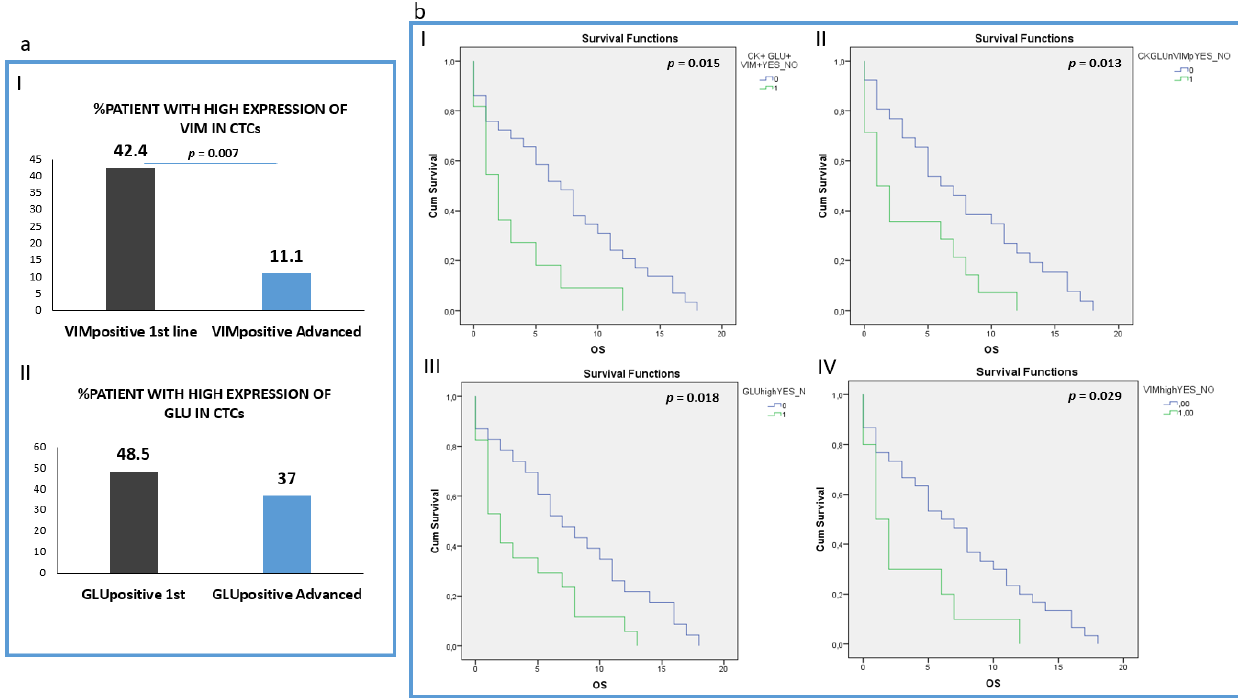
Figure 5. Clinical outcome in NSCLC patients. ( a ) (I) Percentage of treatment naïve (1st line) versus pre-treated (advanced) patients with high VIM expression in their CTCs; (II) Percentage of treatment naïve (1st line) versus pre-treated (advanced) patients with high GLU expression in their CTCs; ( b ) (I) Overall survival (OS) in patients harboring the (CK+GLU+VIM+) phenotype in their CTCs; (II) Overall survival (OS) in patients harboring the (CK+GLU-VIM+) phenotype in their CTCs; (III) Overall survival (OS) in patients harboring High expression of GLU in their CTCs; (IV) Overall survival (OS) in patients harboring High expression of VIM in their